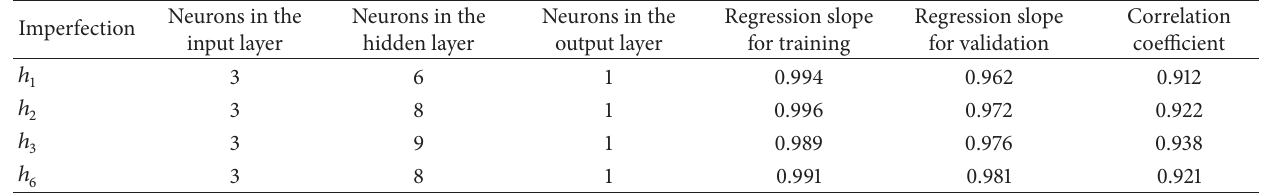
Table 4: Neural network architecture and performance for the direct approach.